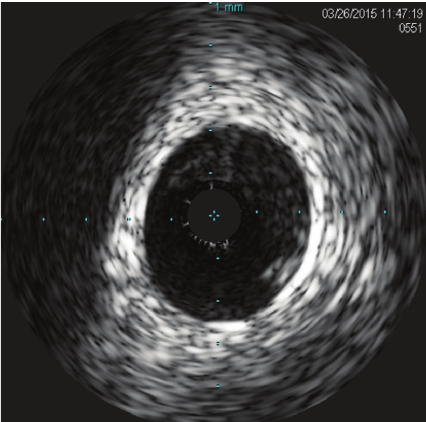
Figure 3: Intravascular ultrasound (IVUS) showing thrombus in proximal LAD, no evidence of